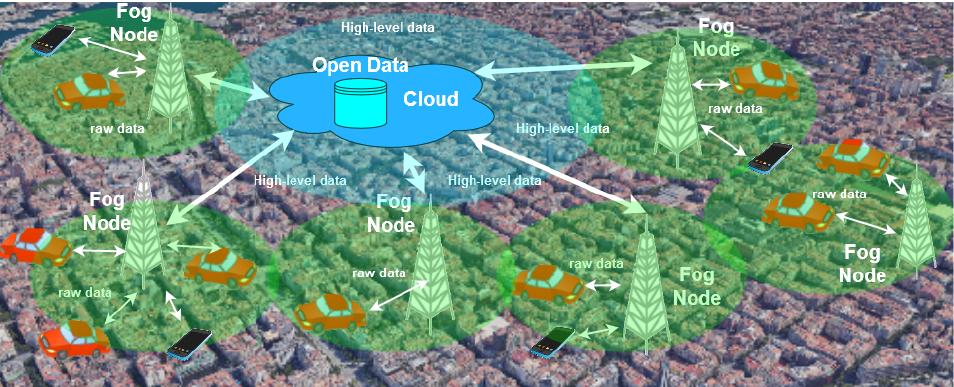
Figure 1. The fog-computing architecture deployed in this work, in which RSUs as are used as fog nodes and the Internet of Vehicles (IoV) as the communication